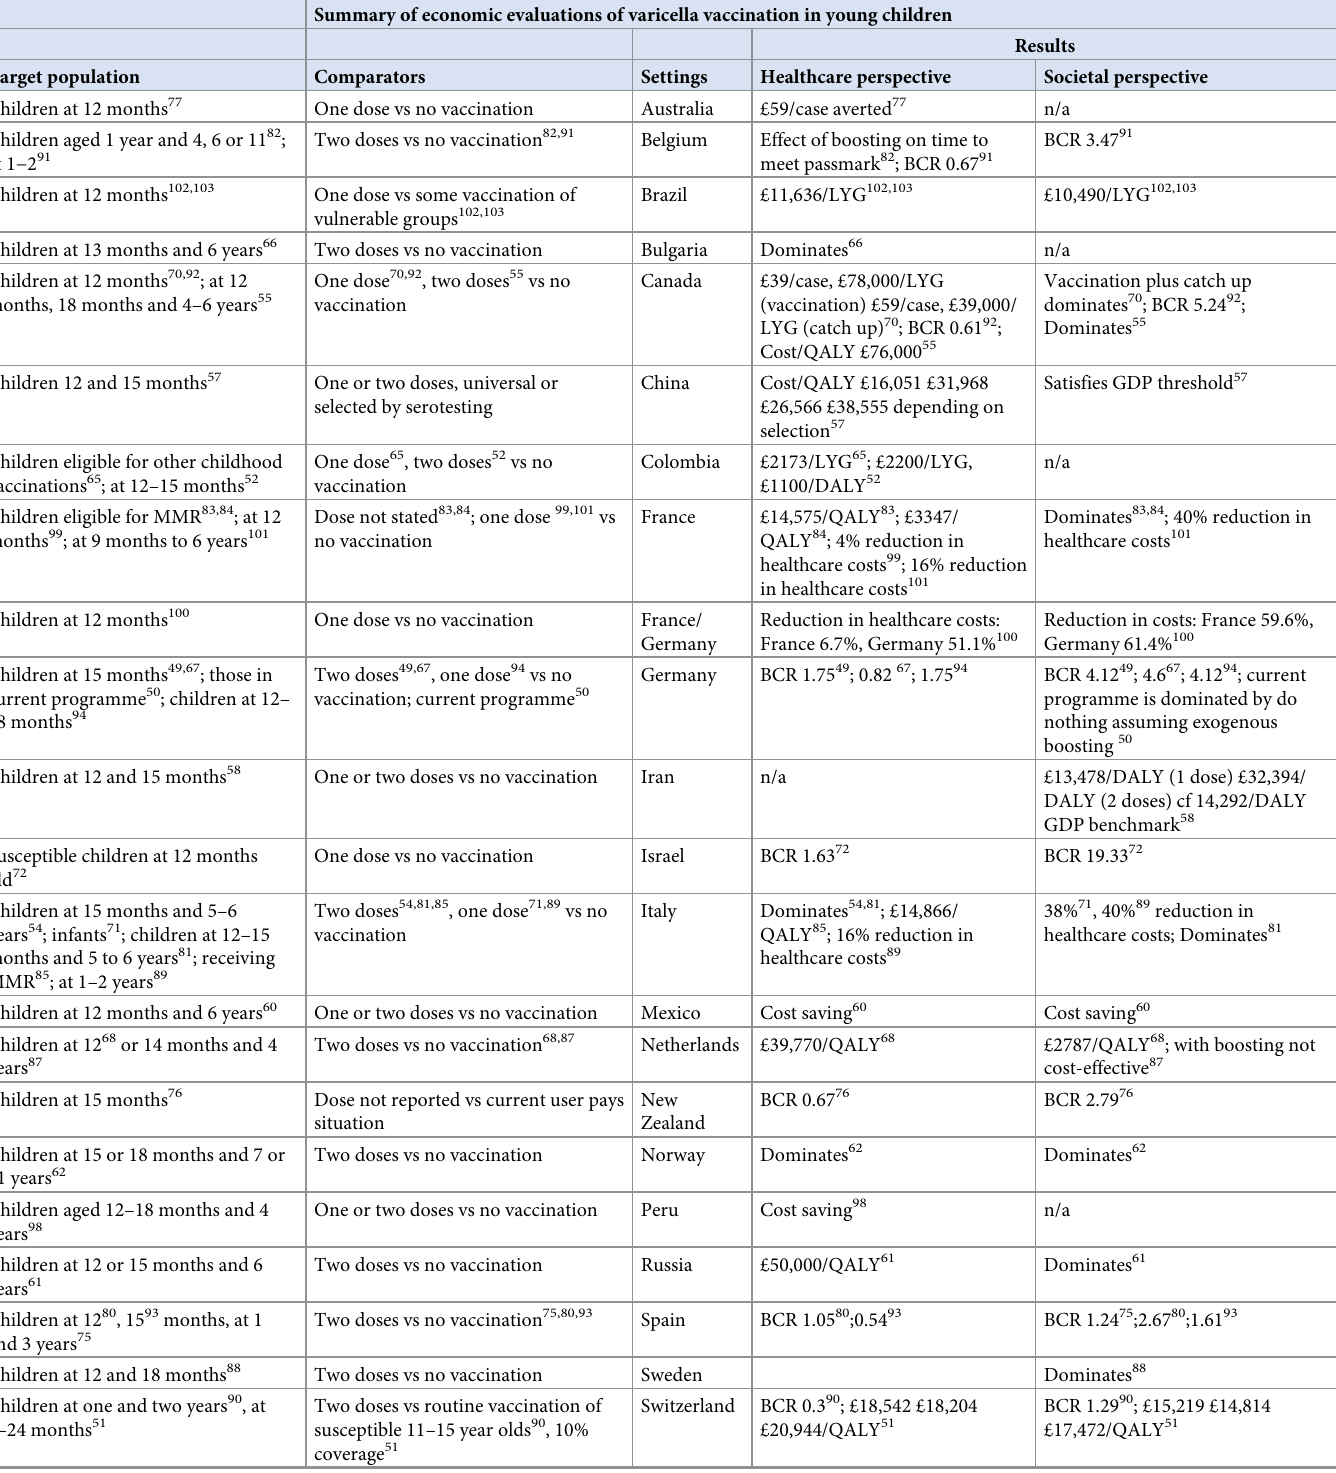
Table 1. Summary of economic evaluations of varicella vaccination by setting and perspective. (Costs are presented in 2021 £ sterling unless otherwise stated). Summary of economic evaluations of varicella vaccination in young